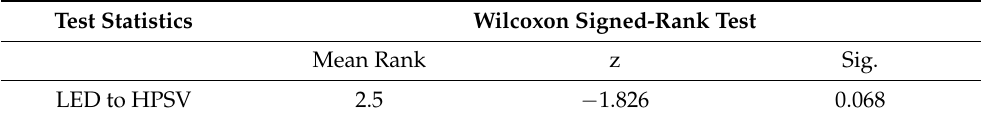
Table 10. The Wilcoxon Signed-Rank Test of eco-efficiency score for HPSV and LED Road Lighting.